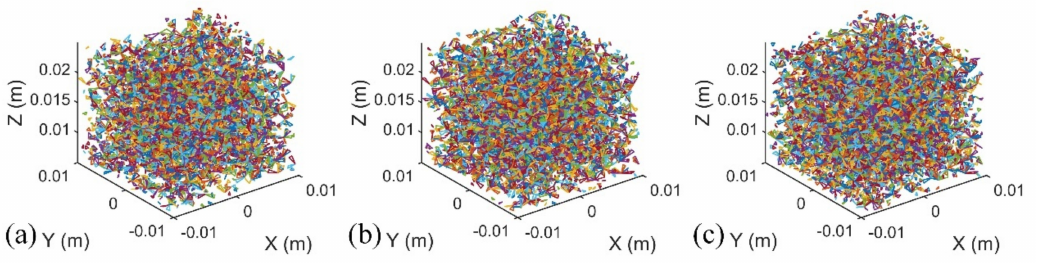
Figure 11. 3-cylces connection for the specimen FC60 at t = ( a ) 0.01 s; ( b ) 0.1 s; and ( c ) 0.2